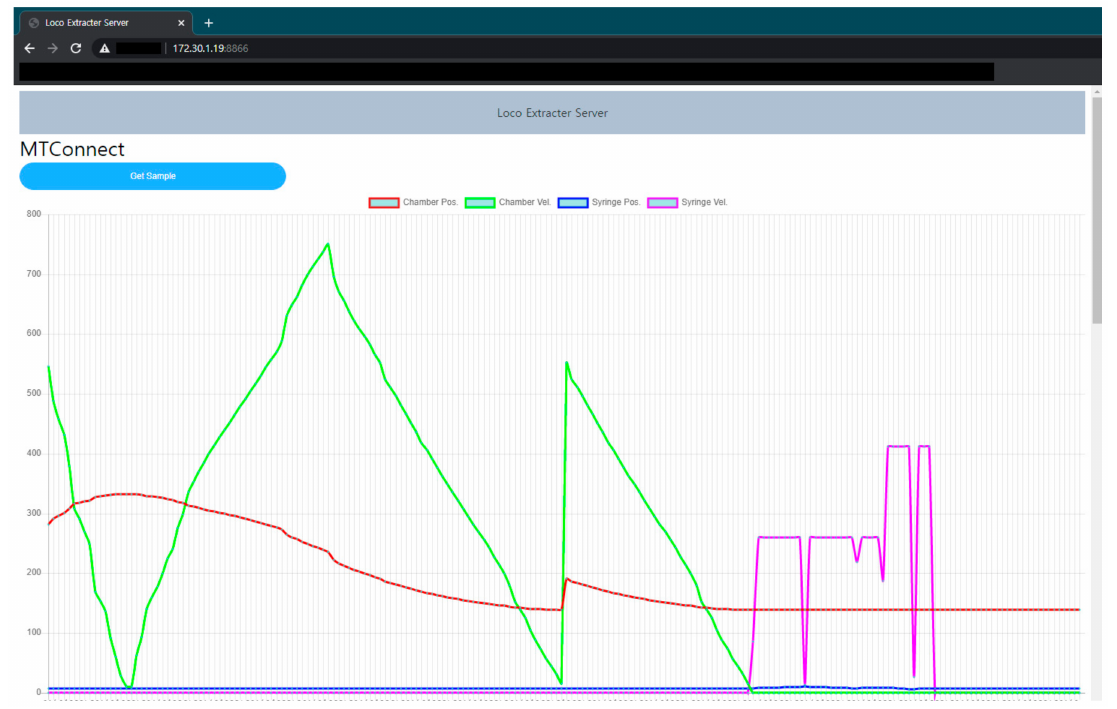
Figure 10. MTConnect monitoring client application charting “Sample” response on a web page.